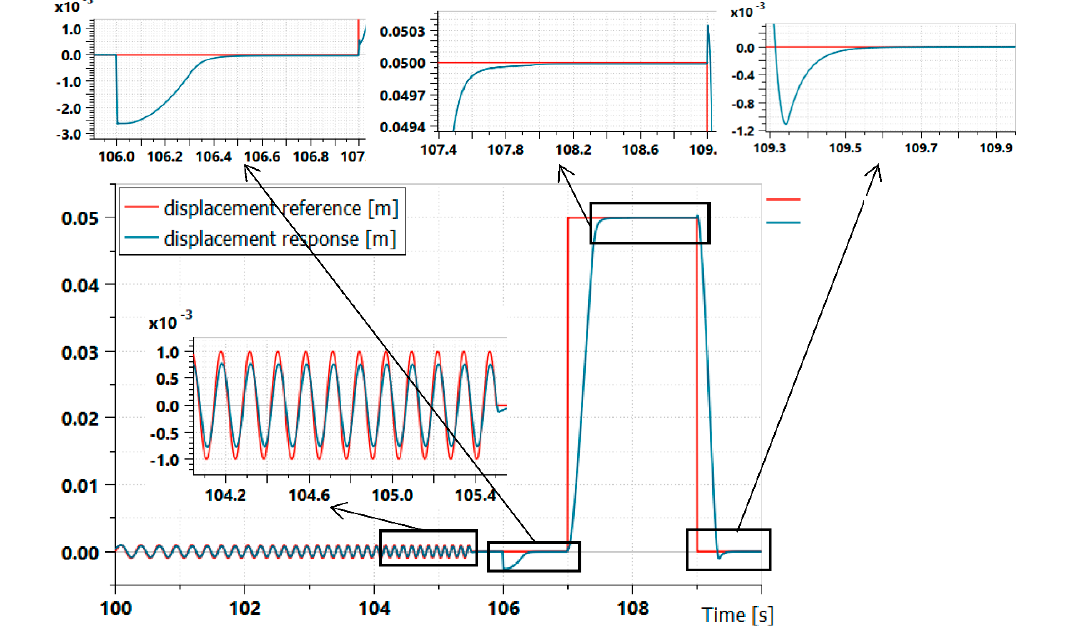
Figure 11. The simulation results reflecting the EHA control performance.